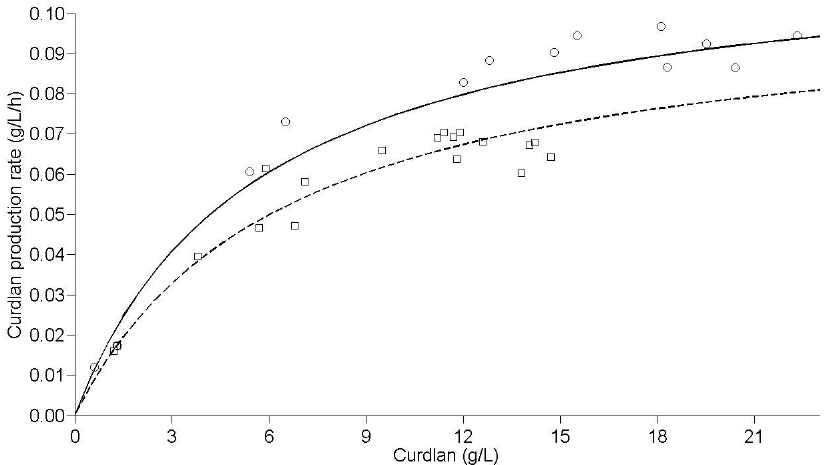
Figure 4. Curdlan production rate by Agrobacterium sp. IFO 13140. Predicted rate (solid line) and observed rate (open circles) for immobilized cells and predicted rate (sectioned line) and observed rate (open squares) for free cells, at 30 °C and 150